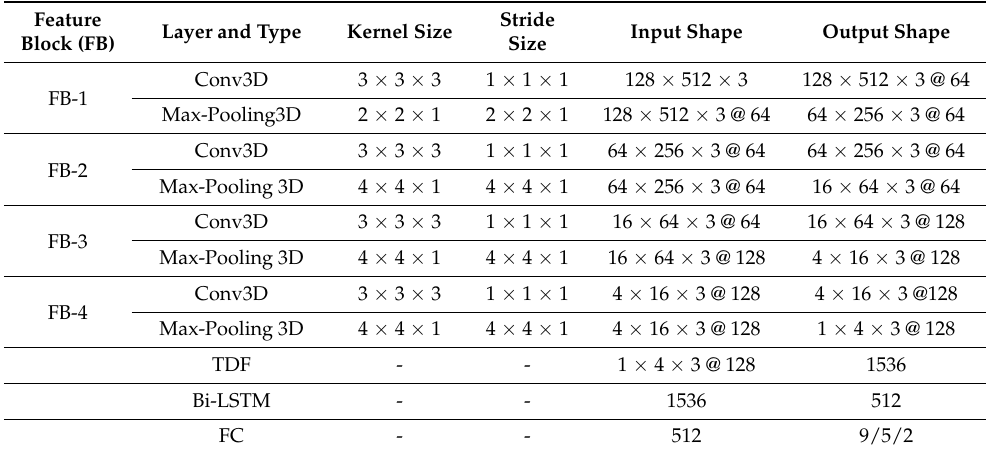
Table 1. The layer parameters of the proposed 3D CNN Bi-LSTM architecture.